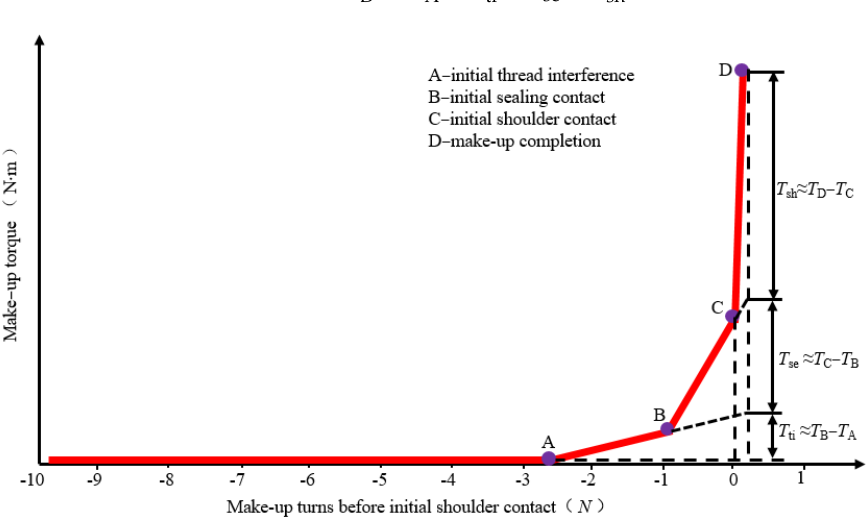
Figure 4. The typical curve between make-up torque and turns for a premium connection. Additional make-up torque from sealing interface T se can be relatively accurately calculated by the torque at the initial contact on sealing interface T B and that on shoulder T C .